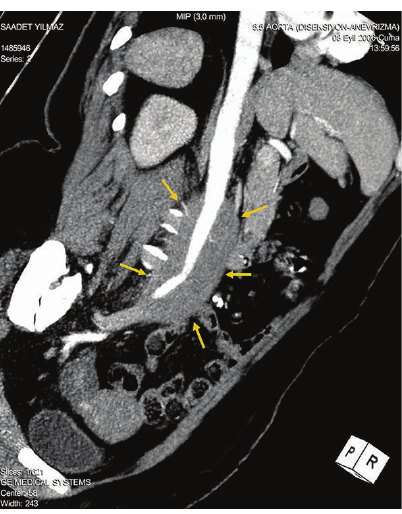
Figure 1: Preoperative contrast-enhanced axial CT images demon- strate that the aorta is surrounded by a soft-tissue mass (yellow arrows).